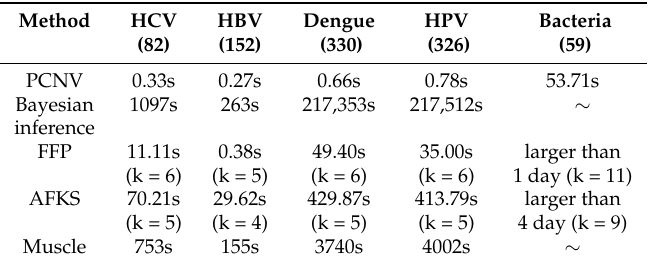
Table 1. Running time for PCNV, Bayesian inference, FFP, AFKS, and Muscle methods. “ ∼ ”, unable to compute on